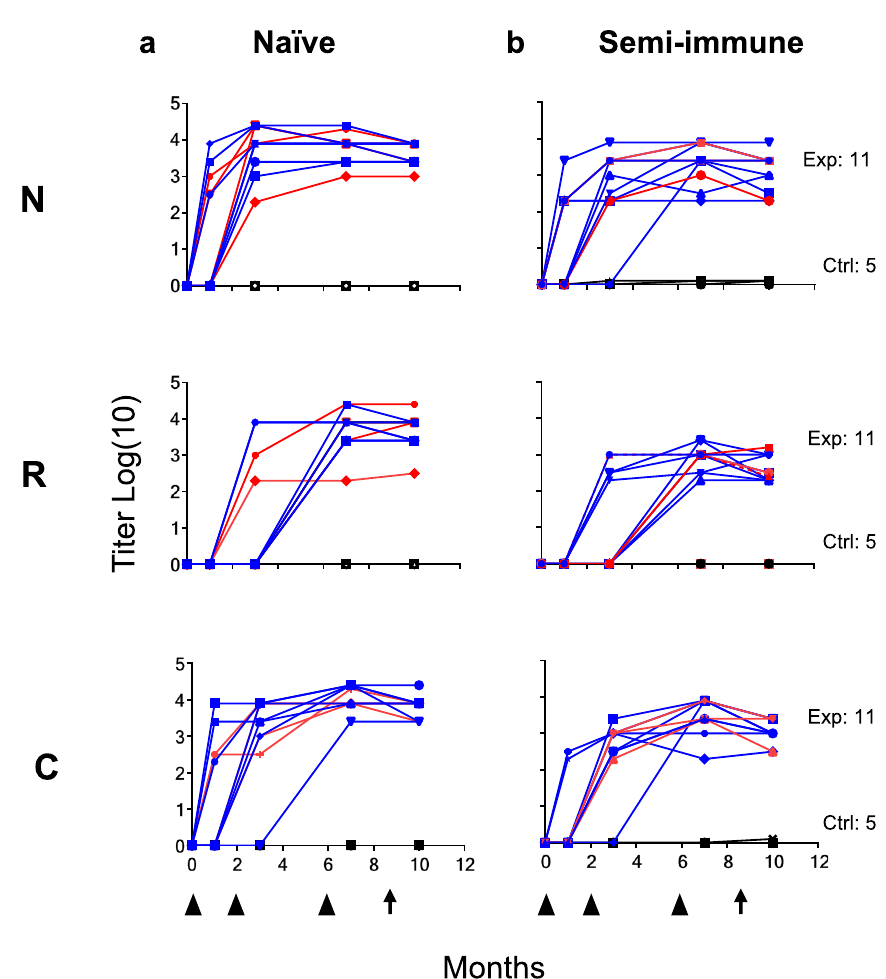
Fig. 3 Anti- Pv CS LSP antibody response in naive and semi-immune volunteers. Kinetics of speci fi c IgG response to N, R, and C fragments in both Exp ( n = 11) and Ctrl ( n = 5) volunteers in Naive ( a ) and Semi-immune groups ( b ). Sterilely protected volunteers are shown in red lines and non-protected in blue lines. Symbols indicate IgG titer as log10 of ELISA values throughout the 10 months of the study. Black triangles at the bottom of the fi gure indicate immunizations (at 0, 2, and 6 months) and black arrows the controlled human malaria infection (CHMI, at month 9). Signi fi cant boosting of antibodies to the three fragments was higher in the naive than in the semi-immune groups (N-, p = 0.046; R-, p = 0.0013; C-, p = 0.00505). Antibody titers did not associate with infection intensity in the naive group (N, p = 0.72; C, p = 0.55; R, p = 0.65) or semi-immune group (N, p = 0.98; C, p = 0.73; R, p = 0.52). Source data are provided as a Source data fi le. Table 2 Number of volunteers reporting vaccine-related adverse events in experimental and control